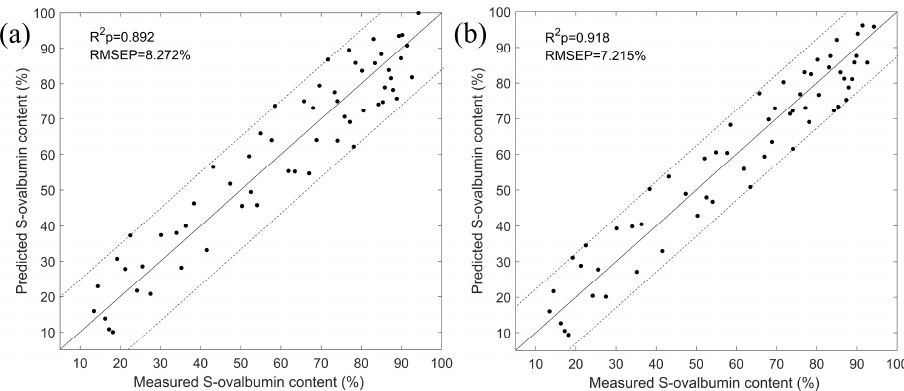
Figure 7. Predicted and measured S-ovalbumin content values for ( a ) PLSR and ( b ) LSSVM models based on feature wavelengths.